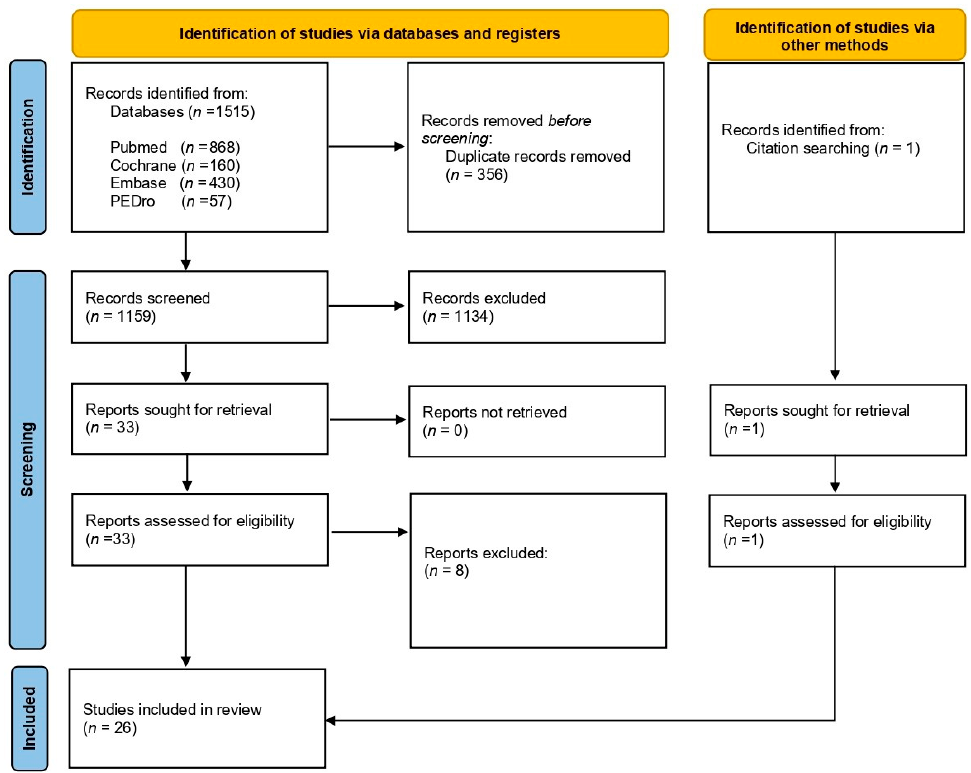
Figure 1. Flowchart of study selection process.